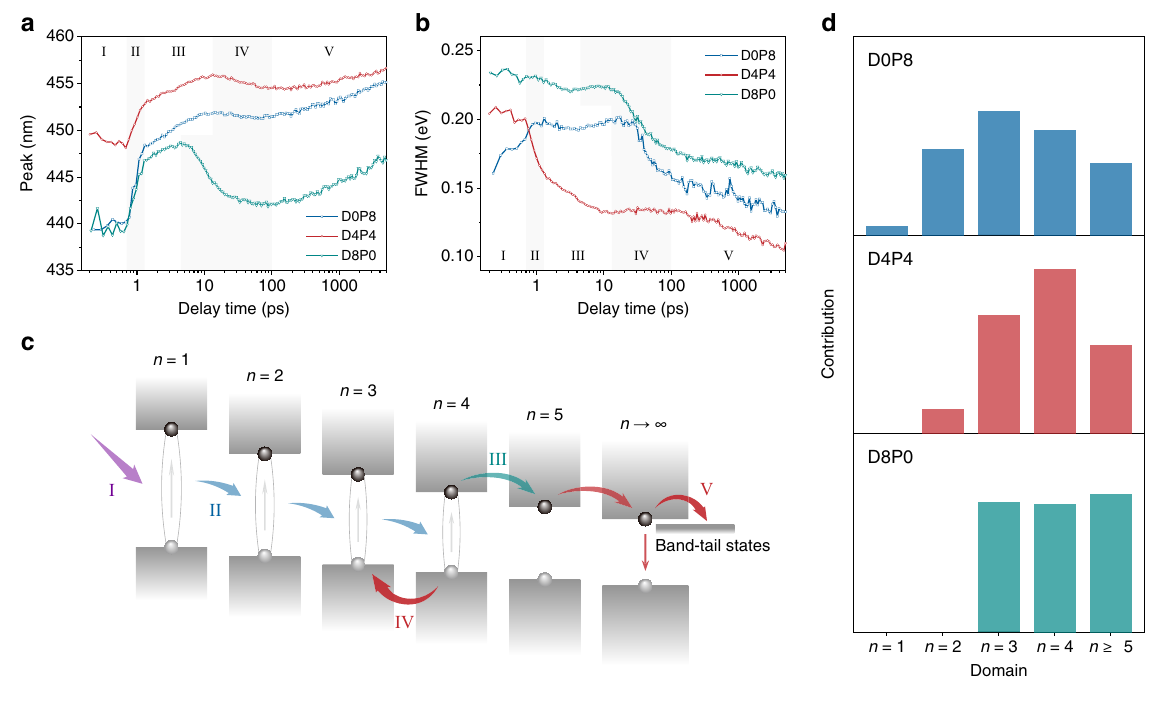
Fig. 4 The effects of QWD on their carrier dynamics. a , b Extracted a peak and b FWHM evolution from the broad bleach peak (425 – 470 nm) for the samples of D0P8, D4P4, and D8P0. c Schematic diagram of carrier behaviors after excitation. The carrier recombination progress can be divided into fi ve stages: I, carrier formation; II, exciton transfer; III, charge transfer; IV, reverse charge transfer; V, continuous charge transfer and recombination. d Contribution of each domain in the CsPbClBr 2 nanocrystal fi lms as estimated from the TA spectra.